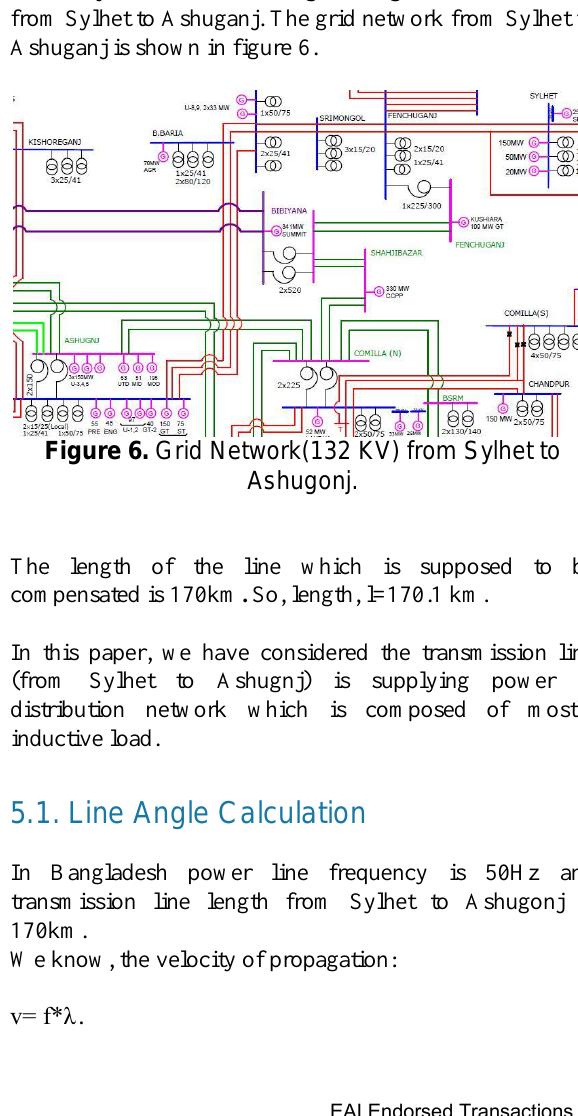
Figure 5. (a)Transmission line (b) P characteristics. (c) V